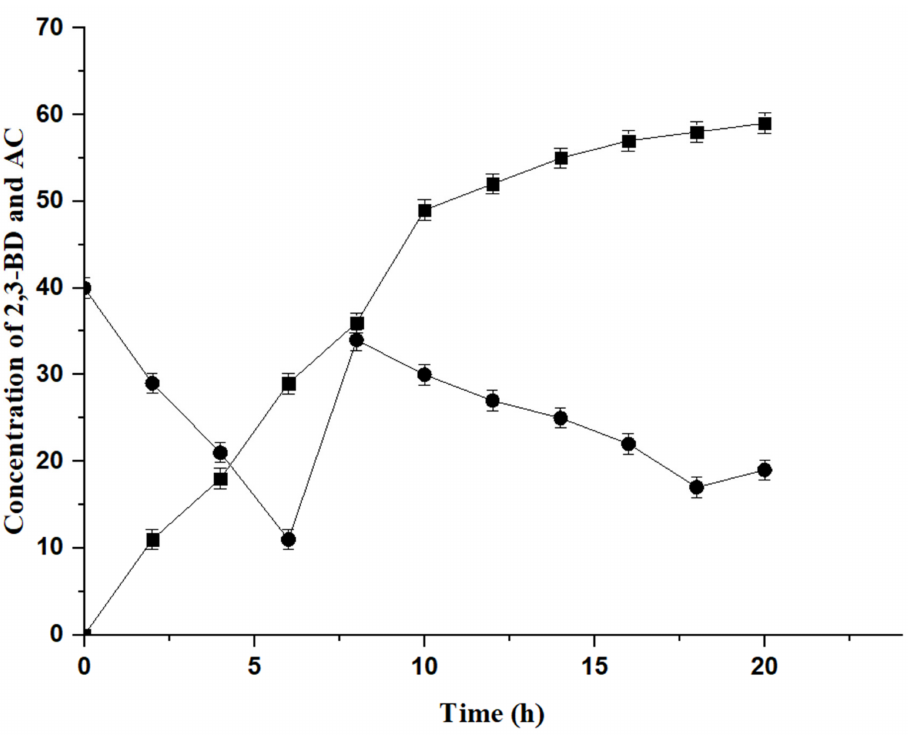
Figure 9. Time course of fed-batch bioconversion by Serratia marcescens MG1ABC (pSWNB+pETDuet- bdhA-yodC). Circular represents 2,3-butanediol. Square represents